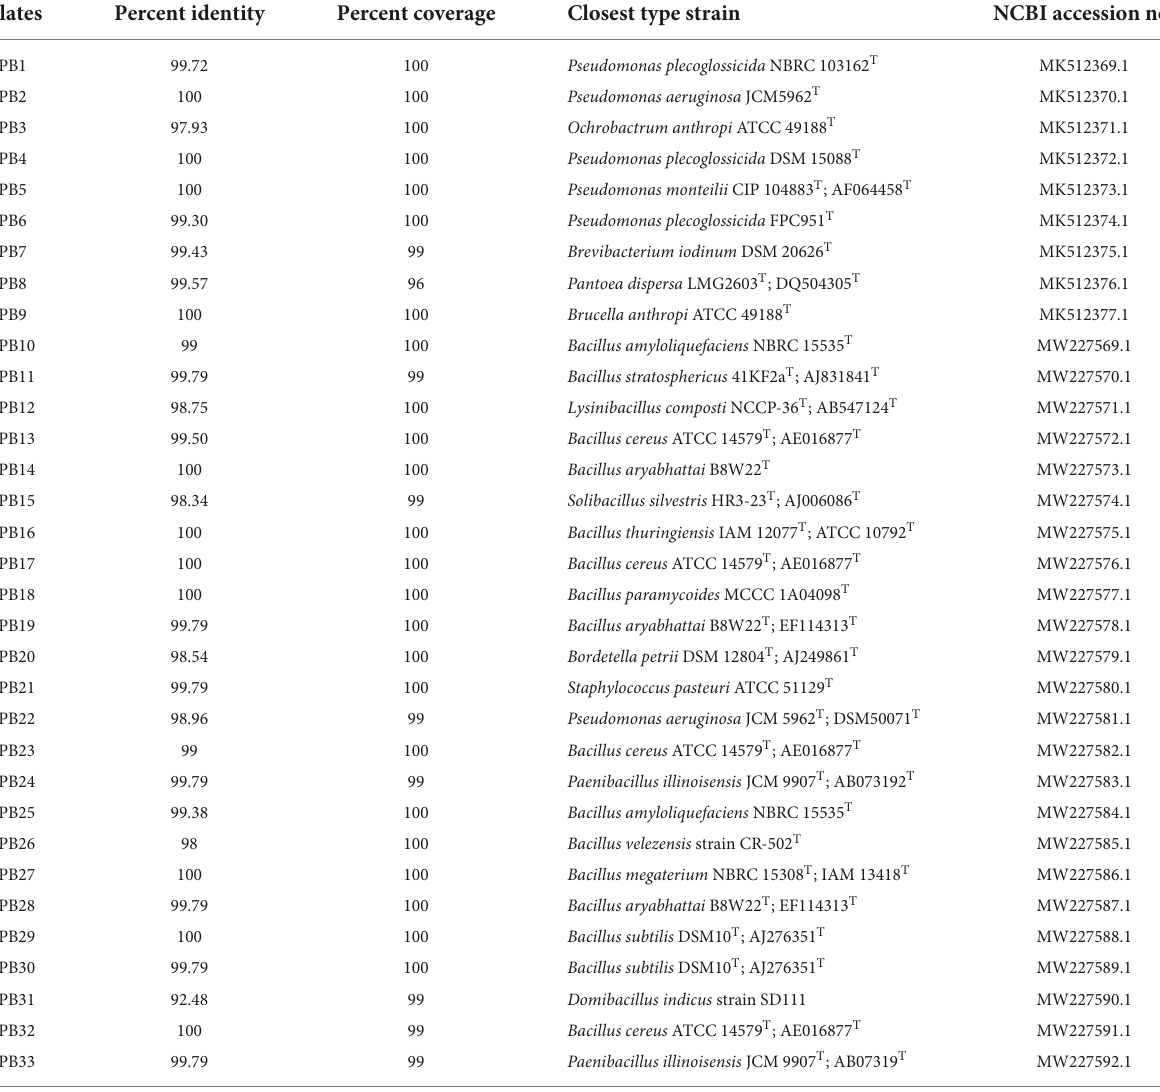
TABLE 2 Primer used in this